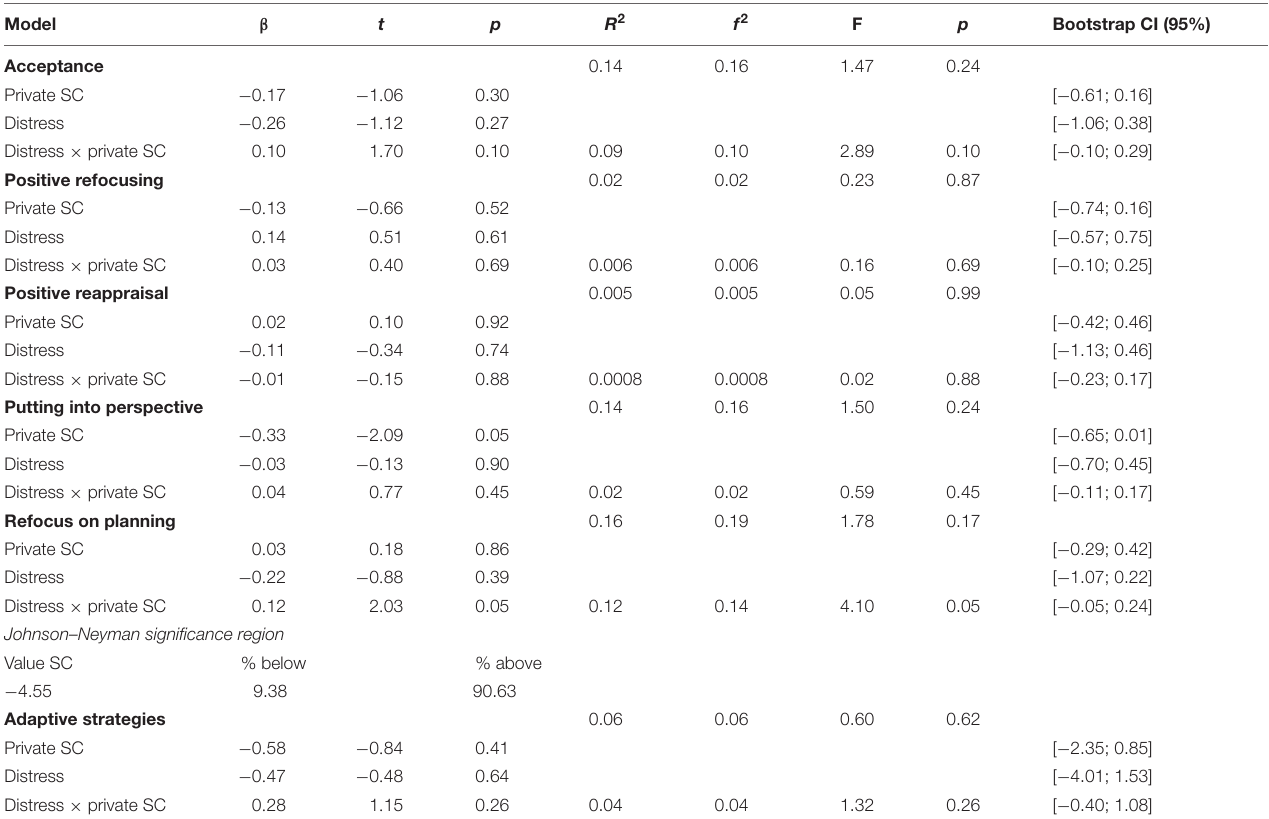
TABLE 4 | Multiple regression analyses predicting adaptive emotion regulation strategies as a function of private SC, distress and their interaction in the binge drinking group.